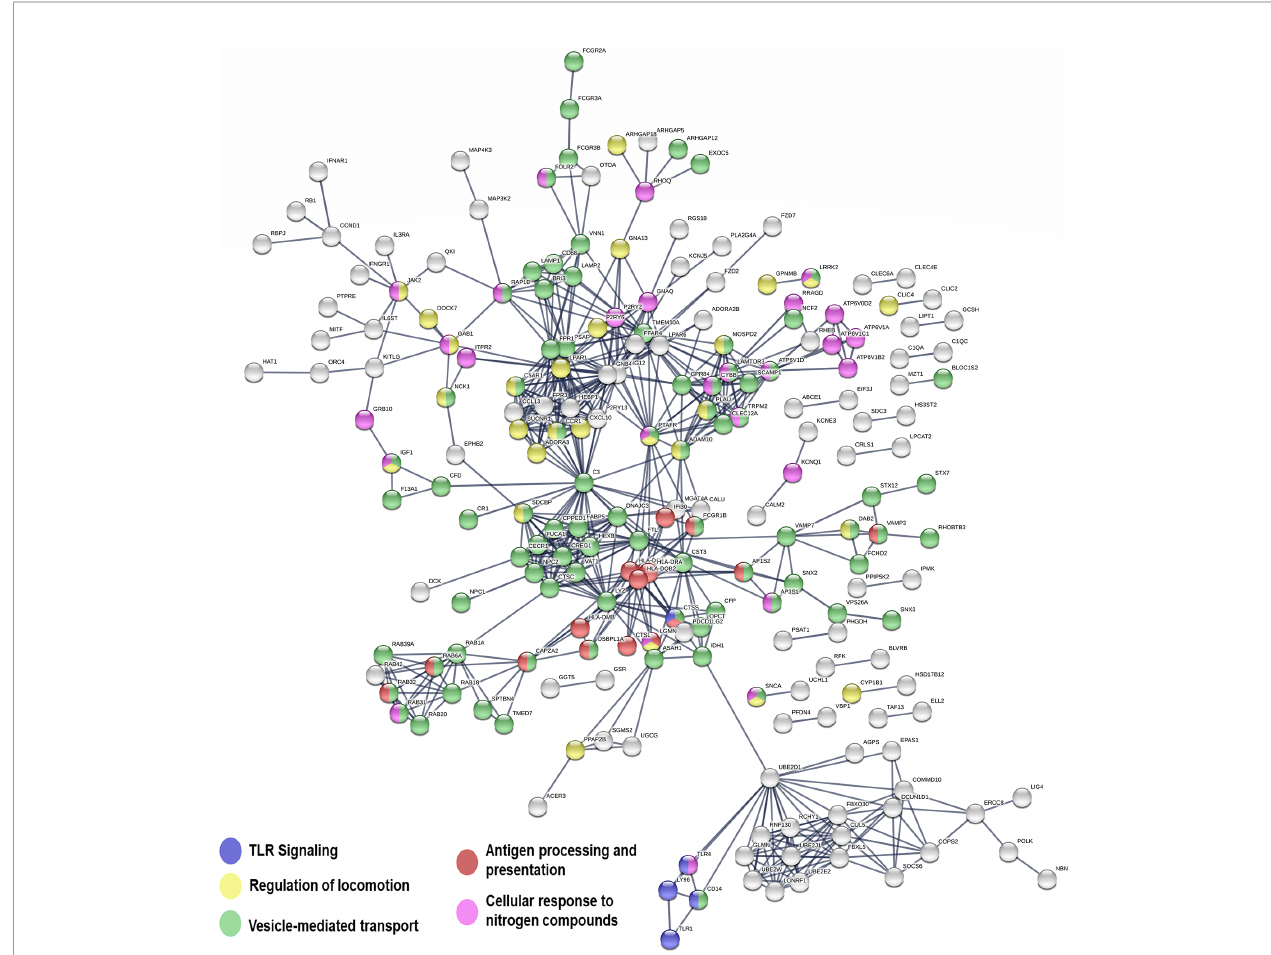
FIGURE 5 | Network representation of genes signi fi cantly upregulated in macrophages infected with CHR vs. SH strains. Line thickness represents the strength of data support (displaying relationships > 0.9 con fi dence value). Interaction sources for network building in STRING included experiments, databases, co-expression, neighborhood, gene fusion and co-occurrence. Nodes not in networks are